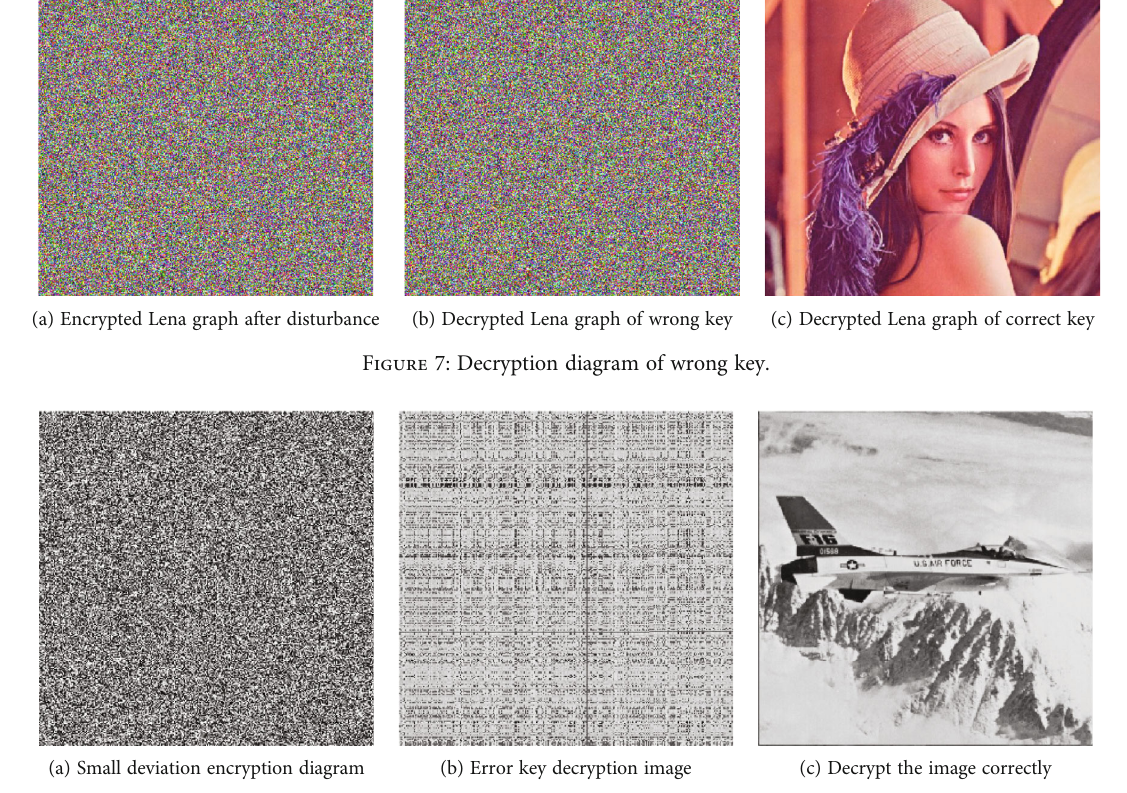
Figure 8: Key sensitivity